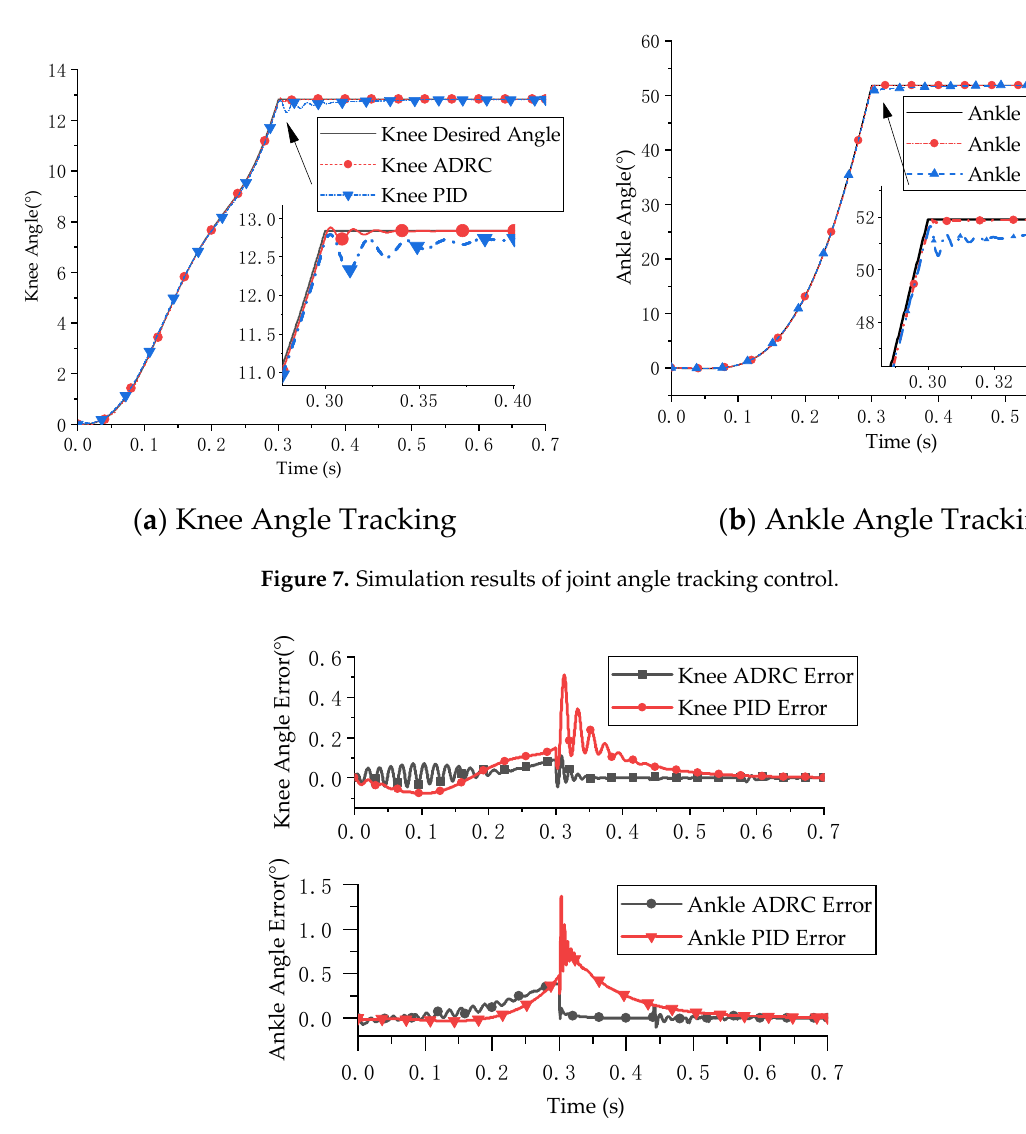
Figure 8. Joint angle tracking error.